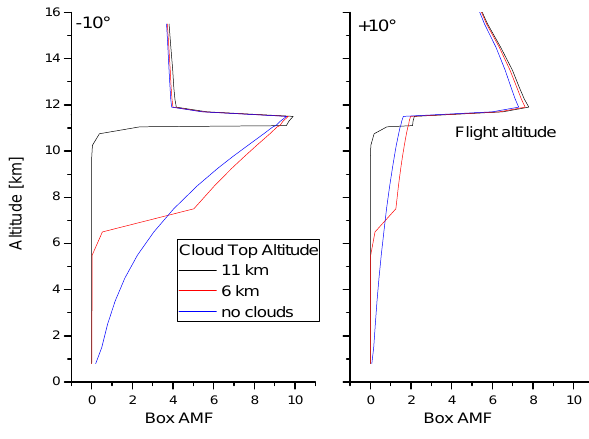
Fig. 1. SO 2 Box-AMF (320nm) for the CARIBIC DOAS instru- ment for two different cloud top altitudes 11 and 6km and cloud free conditions. A typical flight altitude for the CARIBIC Airbus of 11.6km was assumed for the calculation. Close to the cloud top the sensitivity is slightly enhanced due the high reflectivity of the cloud. The cloud’s extinction coefficient was set to 5km − 1 , there- fore the sensitivity decreases rapidly, and is close to zero below the cloud. In order to focus on the influence of the cloud top altitude, no aerosols are included in this